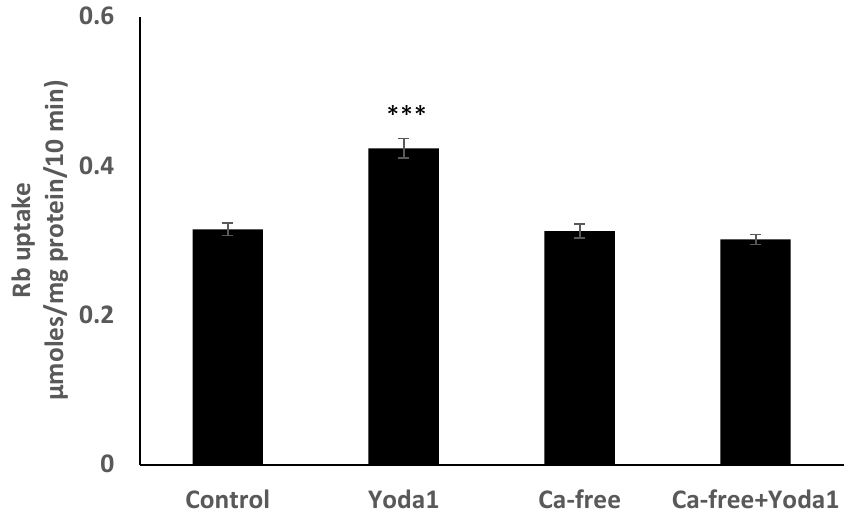
Figure 9. In a calcium-free bathing solution, Yoda1 did not increase the Rb in cultured lens epithelium. Cells were exposed to Yoda1 (1 µ M) for 10 min in either a calcium-free Krebs solution, or in a normal Krebs solution. The values are the mean ± SEM of results from 6 independent experiments. *** indicates a significant difference ( p < 0.001) from the control, as determined by one-way ANOVA followed by Šídák’ s multiple comparison test.